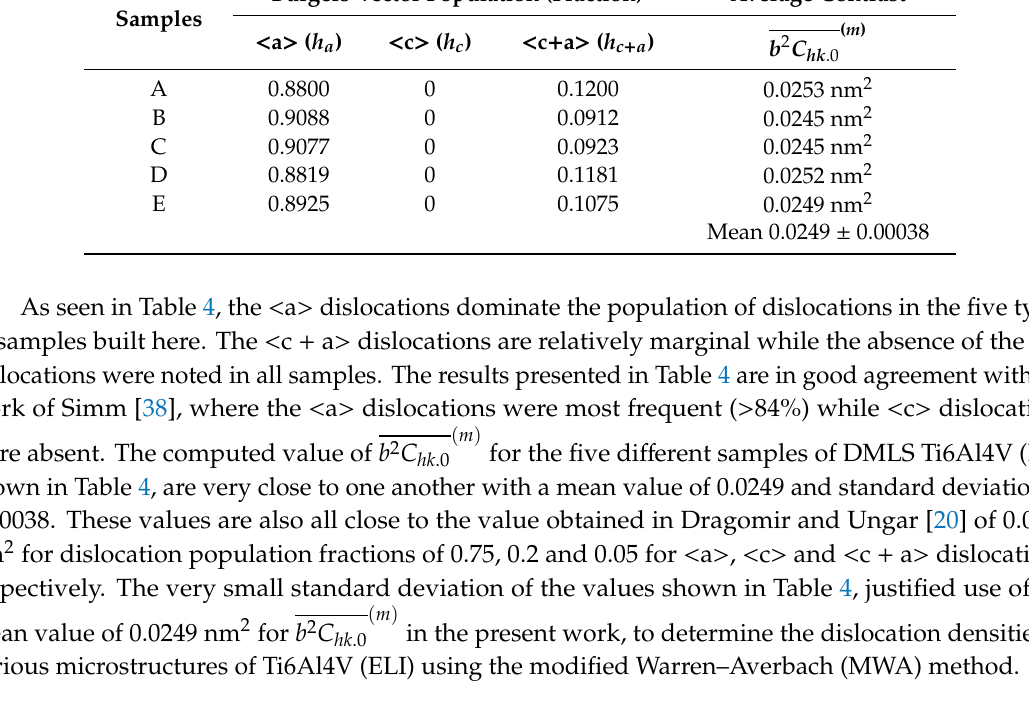
( m ) values for the five di ff erent